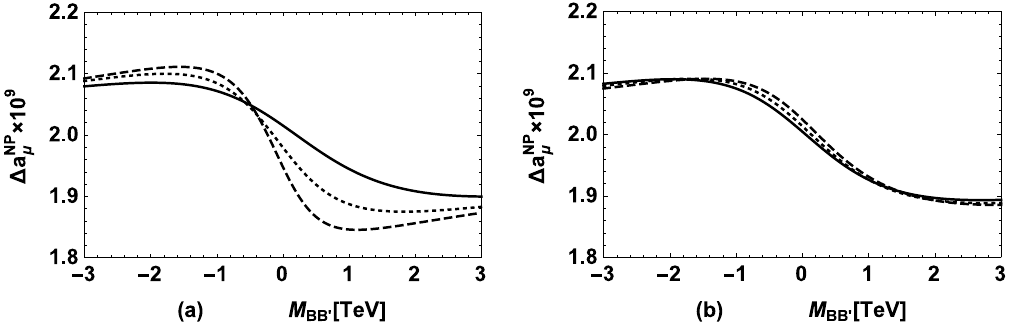
versus g µ YB versus g is plotted for tan β 0 = 1 . 2 (b), where the µ YB = 0 . 3 , 0 . 4 , 0 . 5 respectively. B